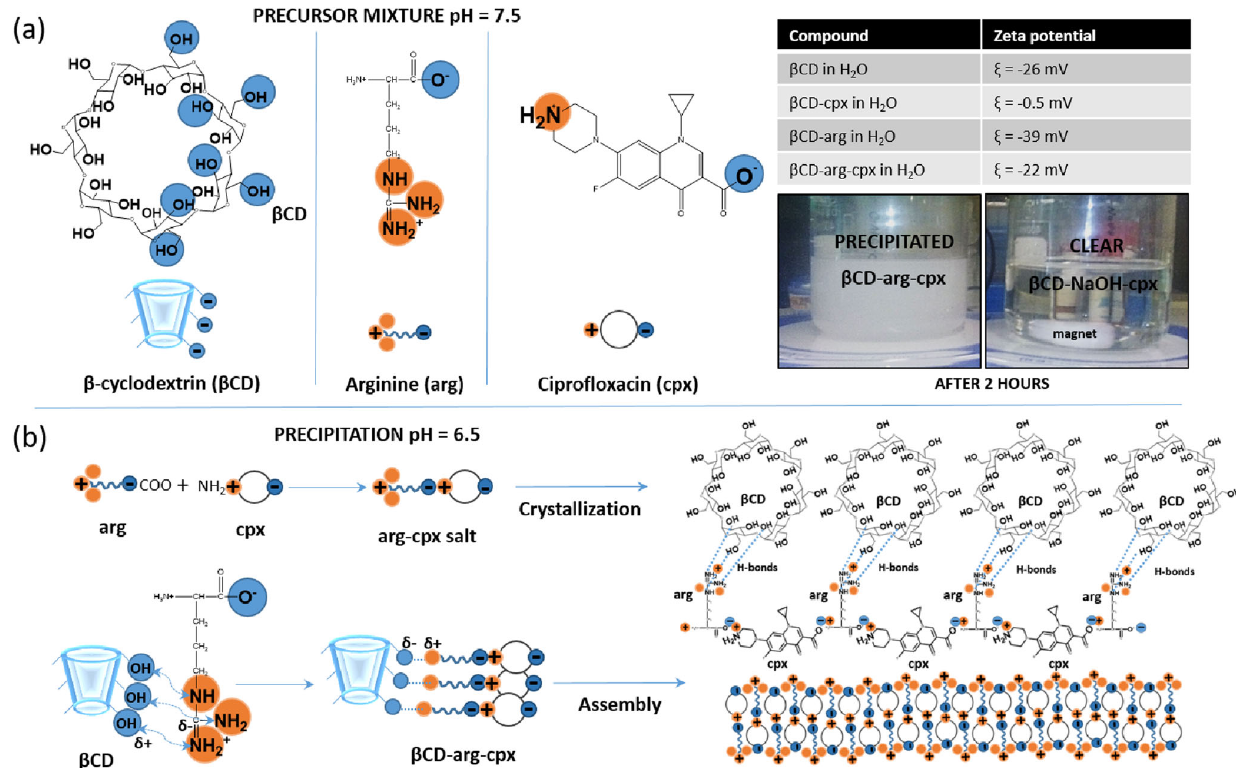
Fig. 3 Formation of more stable complex between cyclodextrin ( β CD), cipro fl oxacin (cpx) and arginine (arg) ( β CD-arg-cpx). Molecular structures of the precursor mixture before precipitation (pH 7.5), zeta potential change for different complex components and precipitation after 2 h of mixing in the case of pH adjustment with arginine (and its delay when arg is replaced with NaOH ( β CD-NaOH-cpx)) ( a ). Precipitation (pH 6.5) involving arg-cpx salt formation and β CD bonding followed by crystallization and assembly ( b